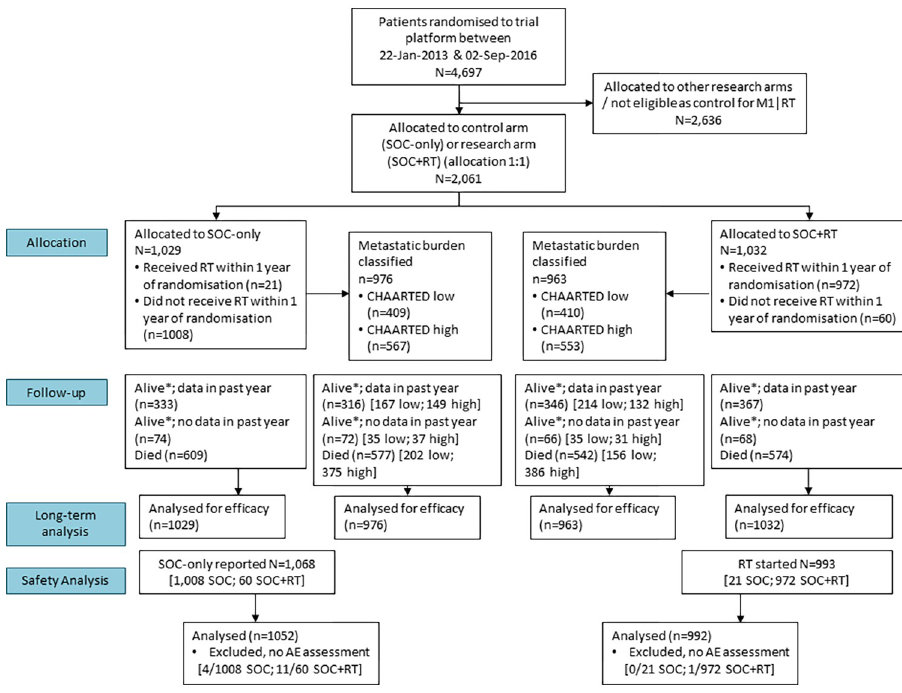
Fig 1. CONSORT diagram. AE, adverse event; CONSORT, Consolidated Standards of Reporting Trials; RT, radiotherapy to the prostate, SOC, standard of care. � Alive, no withdrawal of permission for continued data collection.